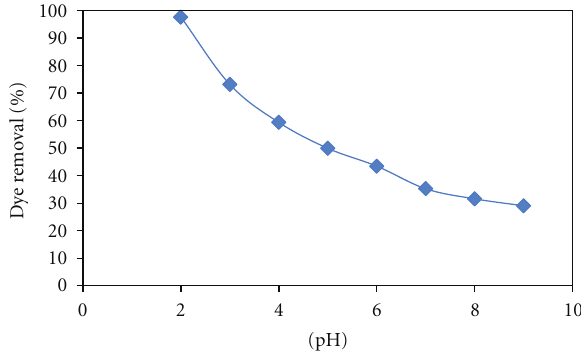
F 6: Effect of initial pH on percentage dye removal, 100ppm dye concentration, and